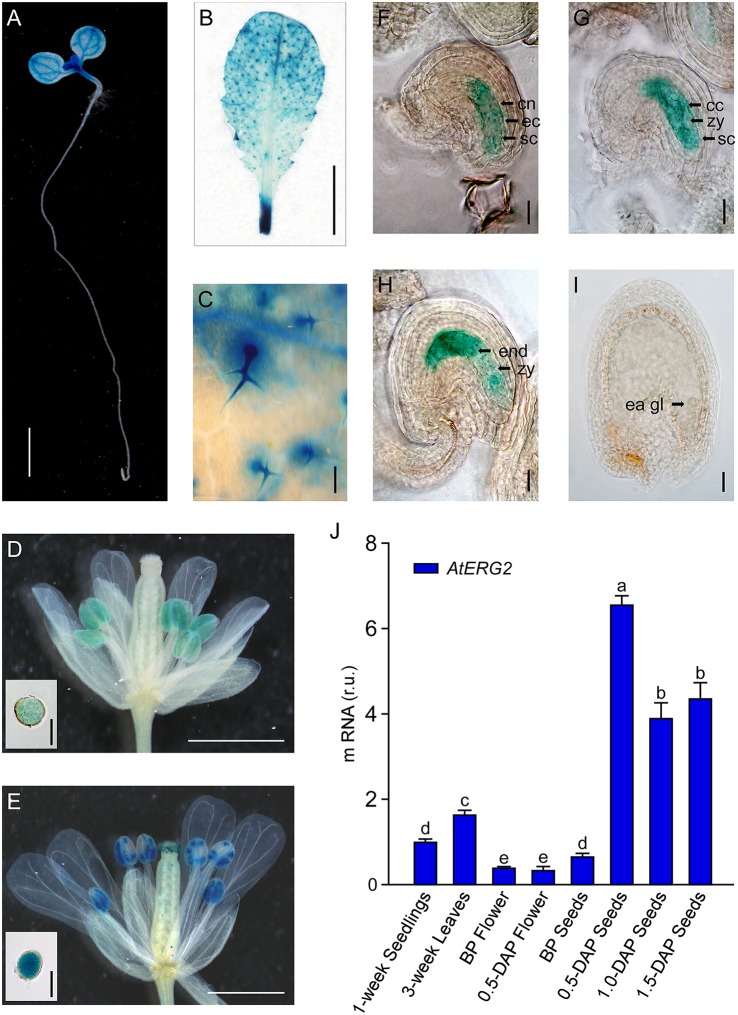
Differential Expression of AtERG2 in pollen and early-stage ovule. GUS staining of PAtERG2::GUS transgenic Arabidopsis plants for 4 h with seedlings and leaves or overnight with flowers and seeds. Bar = 2 mm in (A); 5 mm in (B); 0.2 mm in (C); 0.5 mm in (D,E); 0.05 mm in (F–I); and 0.02 mm in pollen of (D,E). (A)
PAtERG2::GUS fusion staining in 1-week-old Arabidopsis seedling showing GUS activity in cotyledon and shoot apical meristem. (B,C)
PAtERG2::GUS fusion staining in 4-week-old Arabidopsis leaves and leaf trichome. (D,E)
PAtERG2::GUS fusion staining in flowers and pollen at BP (before pollination) and 0.5 DAP (day after pollination), respectively. (F–I)
PAtERG2::GUS fusion staining in developed seeds at BP, 0.5, 1.0, and 1.5 DAP, respectively. The central polar nuclei are indicated by cn; the egg cells are indicated by ec; the synergid cells are indicated by sc; the central triploid nucleus is indicated by cc; the endosperm are indicated by end; the embryos at zygote are indicated by zy; and the early globe-stage embryos (with fewer than four cells in a single embryo) are indicated by ea gl. (J) The transcription level of AtERG2 is detected by qRT-PCR in different tissues of Arabidopsis. UBQ10 was used as internal control. Error bars indicate the SD of three biological replicates. Different letters (a–e) indicate statistically significant differences (p < 0.05) according to Tukey's multiple range test.